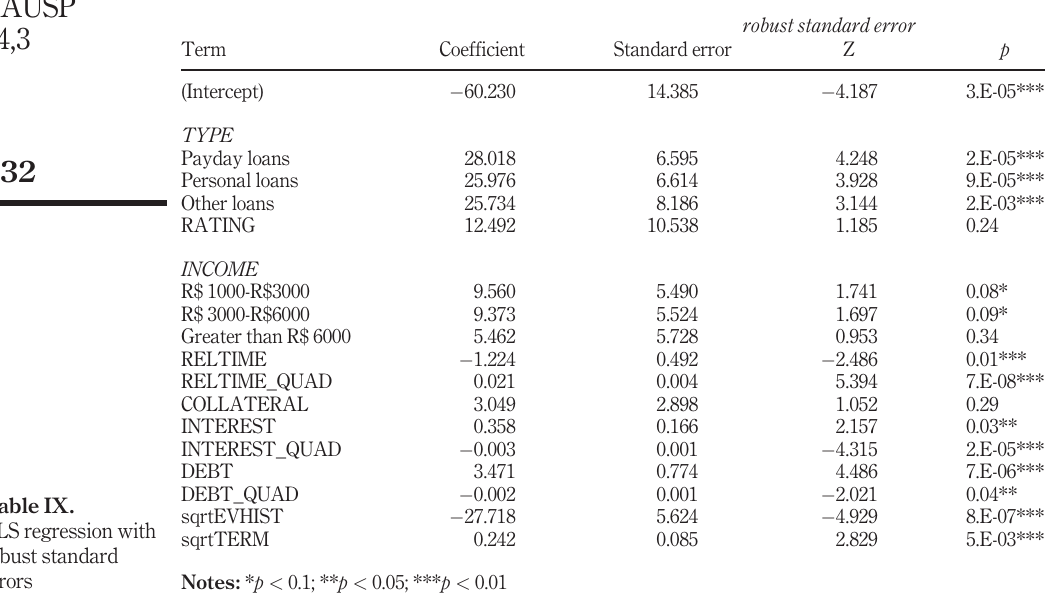
Table IX. OLS regression with robust standard errors